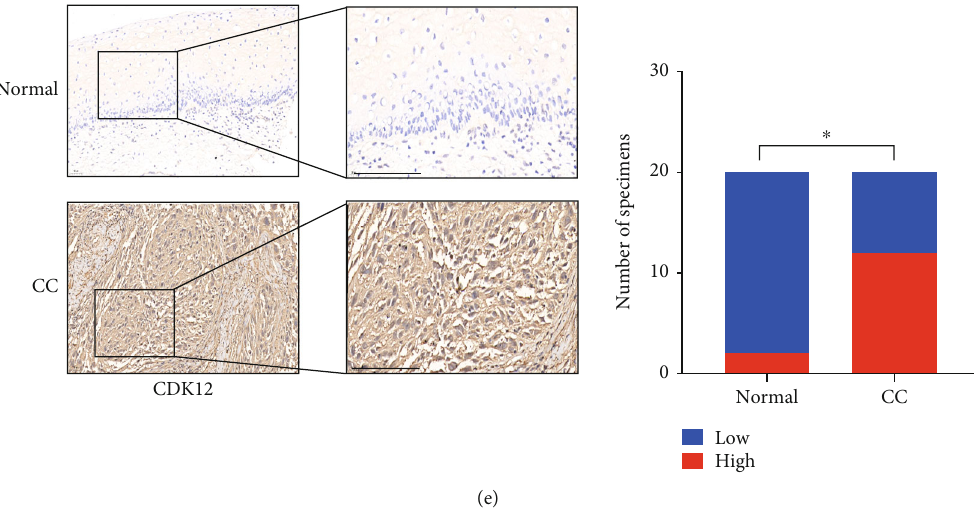
Figure 1: Cyclin-dependent kinase 12 ( CDK12 ) overexpression and its correlation with a poor prognosis in cervical cancer (CC). (a) Analysis of CDK12 genetic alterations across various human cancers using TCGA databases. (b) Kaplan-Meier analysis (log-rank test) of the overall survival of patients with CC based on CDK12 genetic alteration, using TCGA databases. (c) Expression pro fi les of CDK12 in tumors (T) and normal (N) cervical tissue samples GSE6791, which are from Gene Expression Omnibus datasets. (d) Expression pro fi les of CDK12 in precancerous lesions of the uterine cervix, NC and CC samples from GSE7803. NC: normal cervix; HSIL: high-grade squamous intraepithelial lesion. (e) Representative immunohistochemical images and quanti fi cation analysis showing CDK12 expression in human cervical cancer and normal uterine cervix tissue specimens from Sixth hospital (sixth cohort). Scale bar: 200 μ m. Two-tailed t -test, ∗ P < 0 : 05